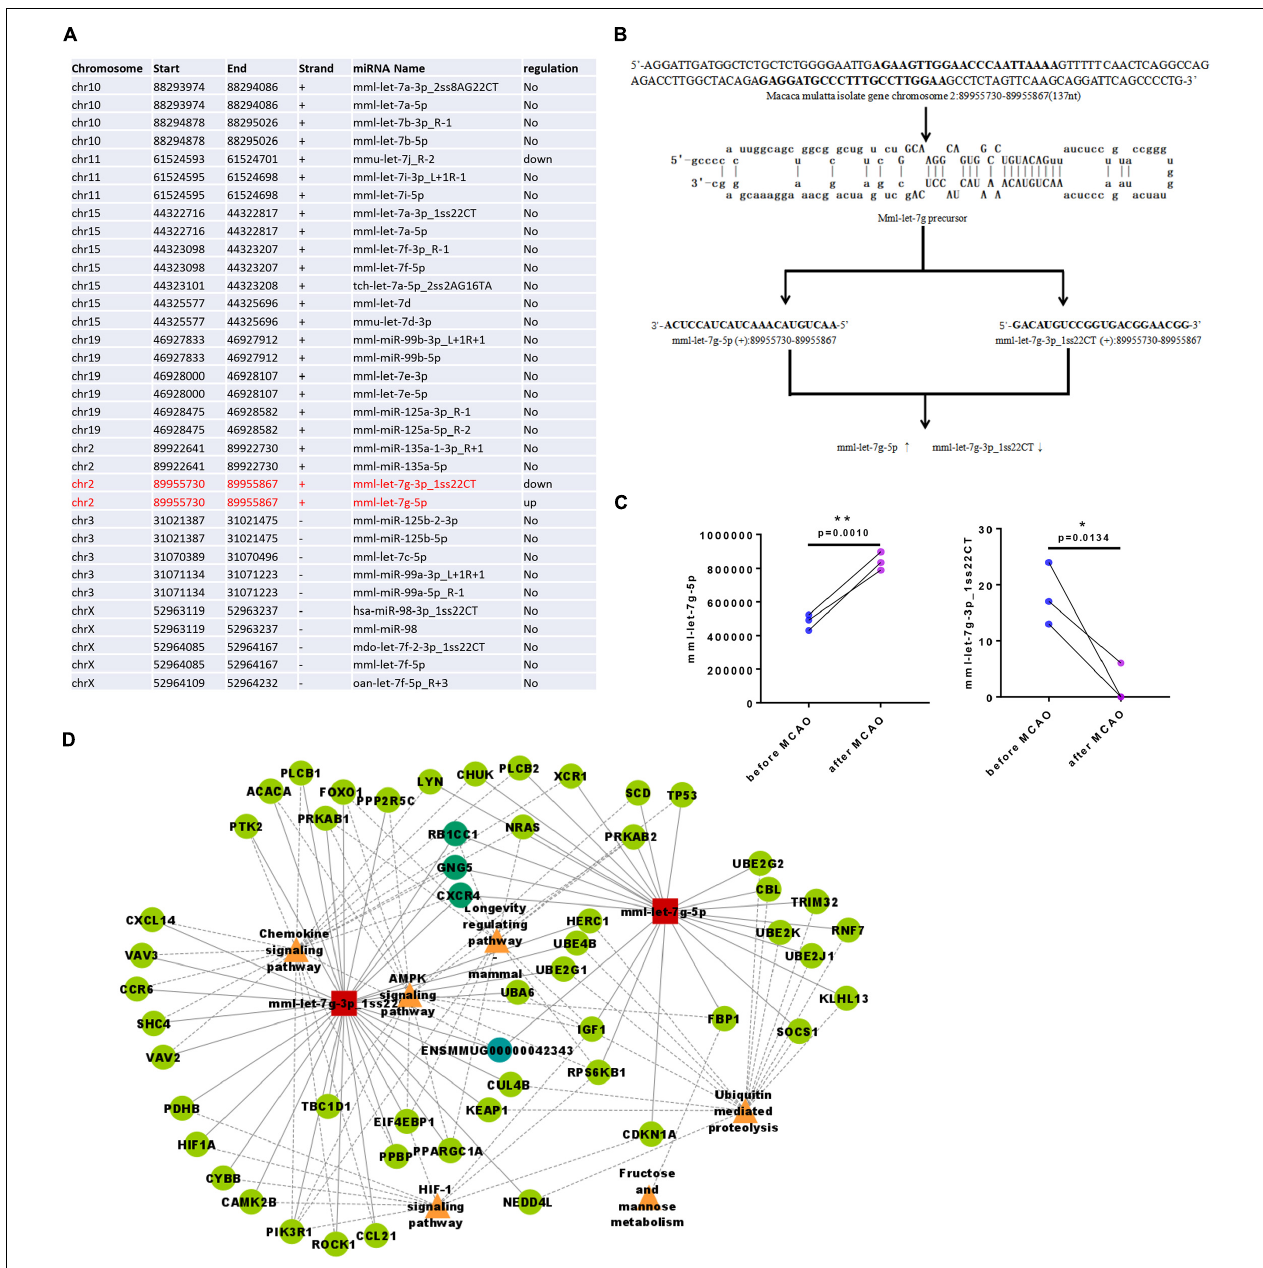
FIGURE 4 | Clustering analysis of miRNA expression of rhesus monkey. (A) mml-let-7g-5p and mml-let-7g-3p_1ss22CT belongs to one cluster. (B) The stem-loop structures of the two pre-miRNAs that can yield mature miRNA sequences (mml-let-7g-5p and mml-let-7g-3p_1ss22CT). (C) mml-let-7g-5p and mml-let-7g-3p_1ss22CT were reversely changed following ischemia. (D) Through miRNA-gene-KEGG pathway analysis, mml-let-7g-5p, and mml-let-7g-3p_1ss22CT which share three same target genes such as RB1-inducible coiled-coil 1 (RB1CC1), G-protein subunit γ 5 (GNG5), and chemokine (C-X-C motif) receptor 4 (CXCR4), which was involved in chemokine signaling pathway, AMPK signaling pathway, longevity regulating pathway, ubiquitin mediated proteolysis, fructose, and mannose